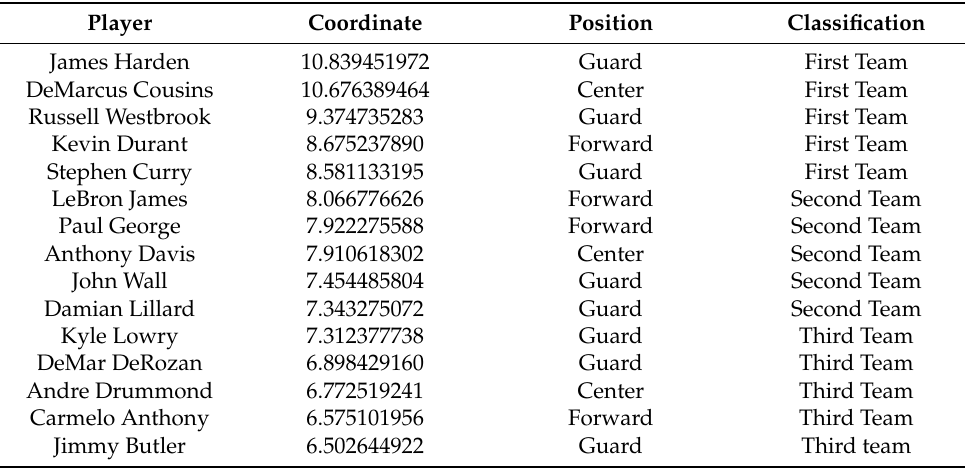
Table A3. All-NBA Teams’ selection through PC1, 2015–16 NBA Season. Player Coordinate